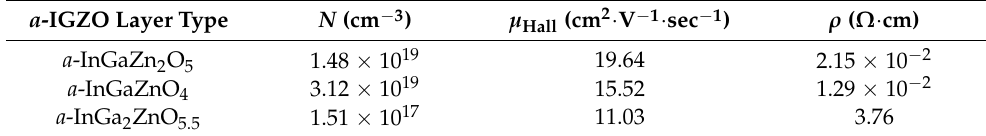
Table 3. Hall measurement result of the various a -IGZO thin films with Ar:O 2 = 20:1.2 (sccm). a -IGZO Layer